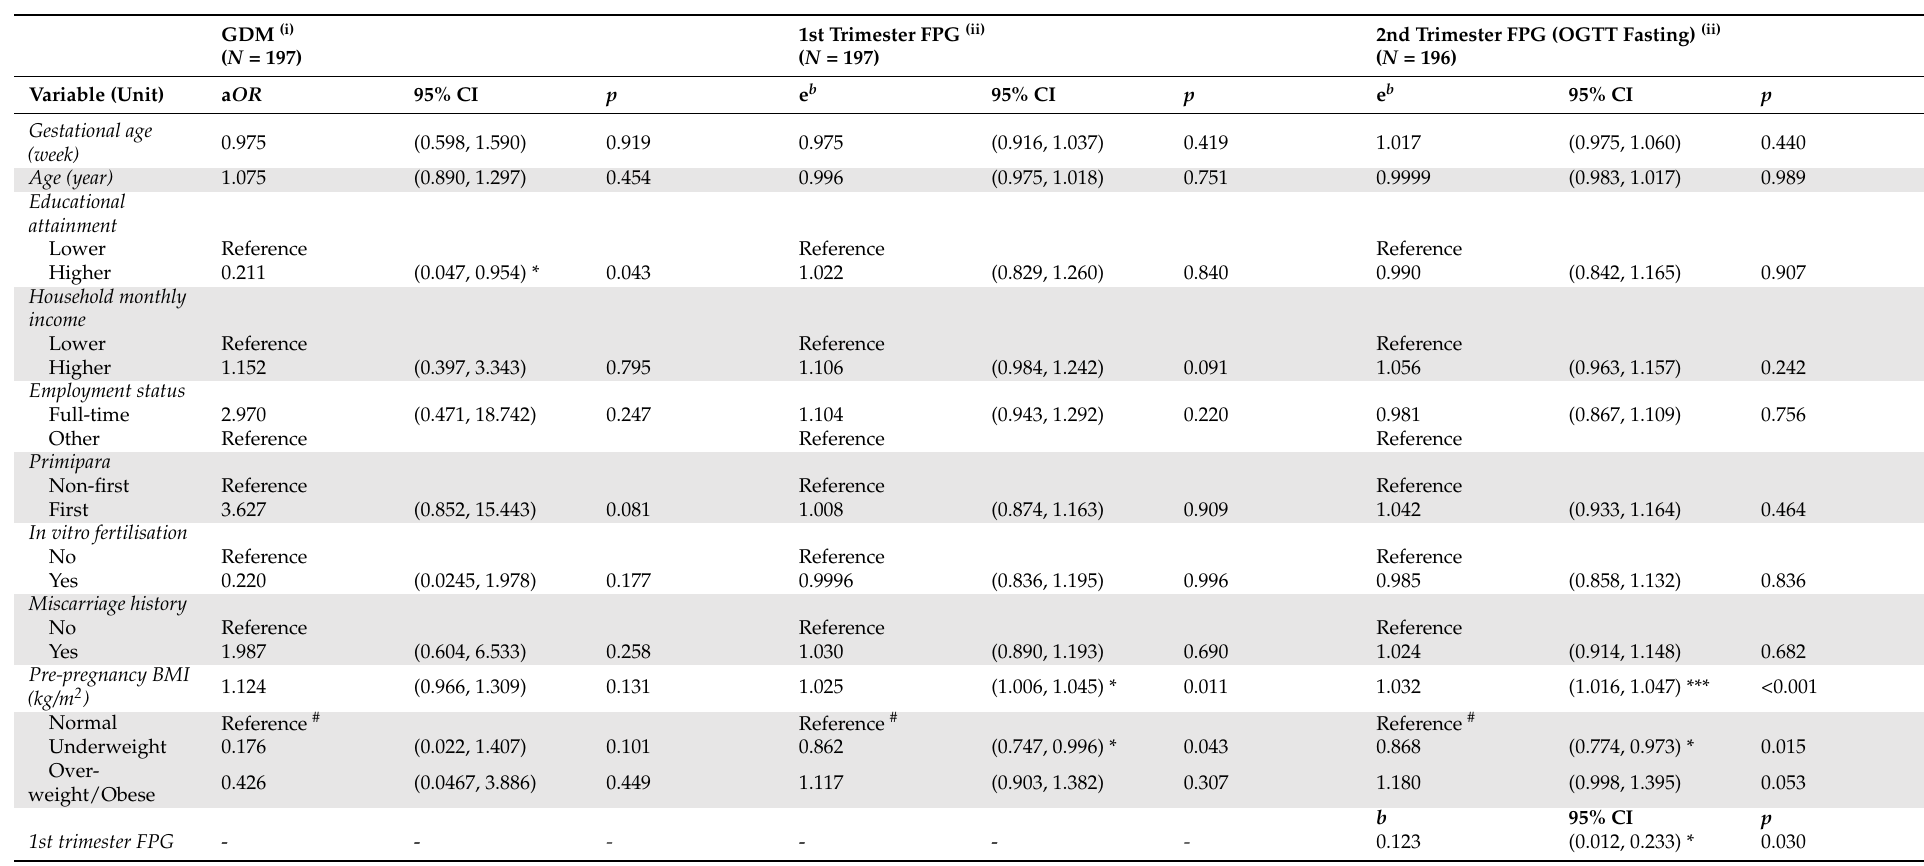
Table 3. Adjusted (multivariable) associations of sociodemographic and health-related characteristics with gestational diabetes mellitus (GDM) and other glucose